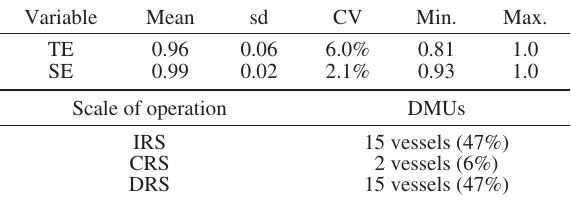
Table 8. – Spearman correlations of technical efficiency (TE) and Table 5. – Descriptive statistics of technical efficiency (TE), scale scale efficiency (SE) scores of the three strategies with presence efficiency (SE) and scale of operation for pesca a congelato (>80%). N=32. IRS, increasing returns to scale; CRS, constant returns to scale; DRS, decreasing returns to scale.